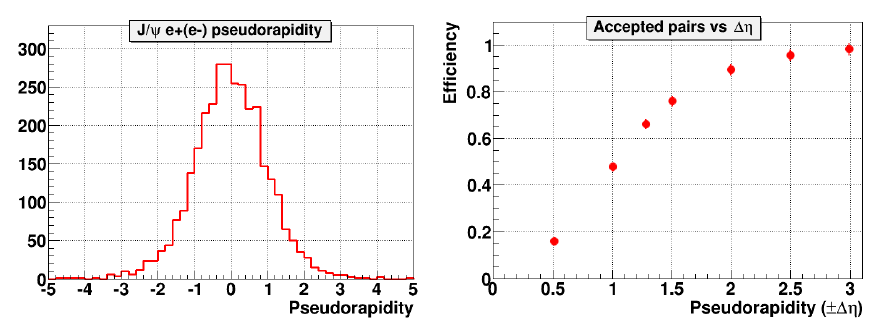
Figure 1 . Left) Pseudorapidity distribution of electrons and positrons from J/ψ decays is quite high (~80% for |ψ decays. Right) percentage of J/ψ decays is quite high (~80% for |ψ → e − e + decays with both the electron and positron within the pseudorapidity window of ± ∆ηη